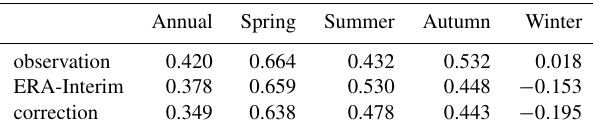
Table 7. Trends ( ◦ C10a − 1 ) of annual and seasonal temperatures over the 24 sites in